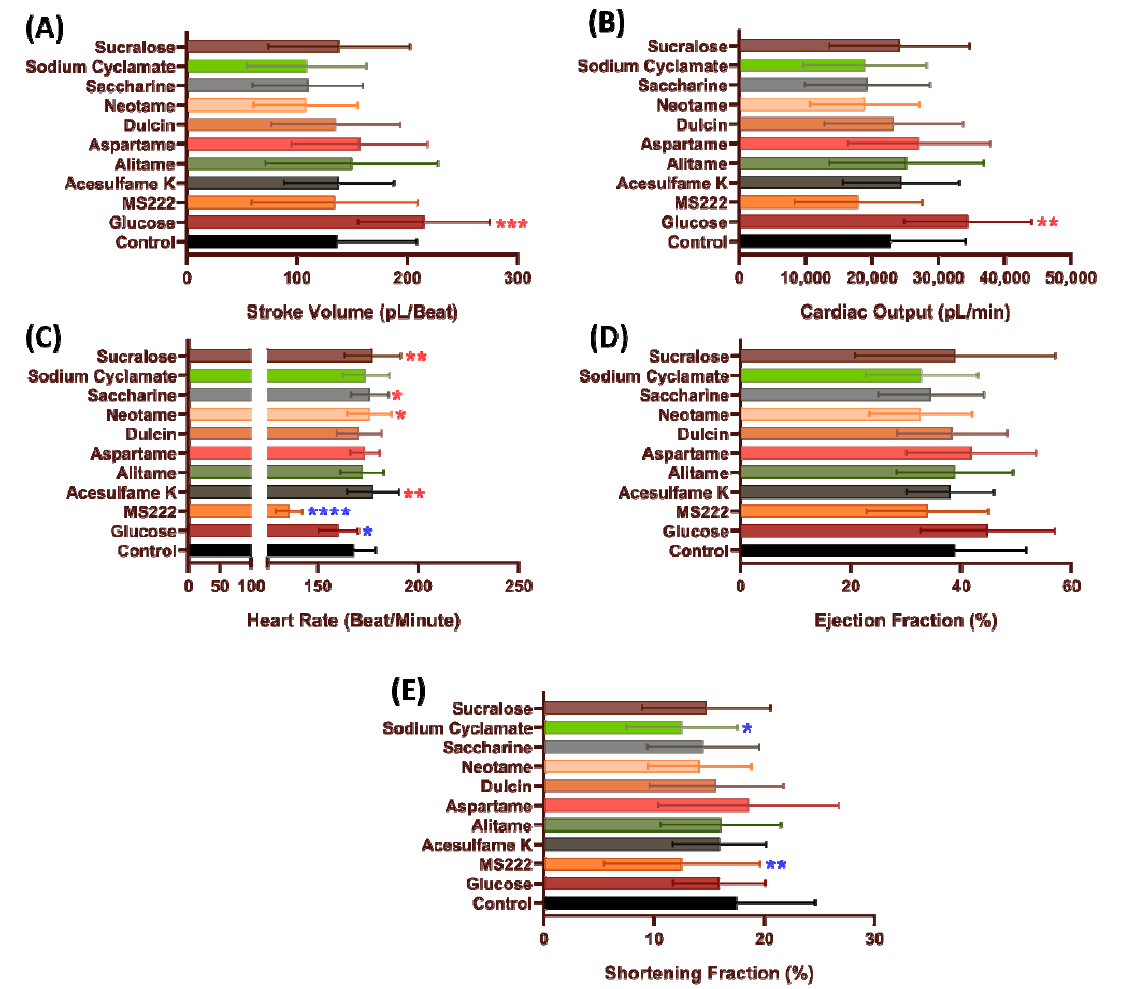
Figure 2. Cardiac performance endpoints for zebrafish after acute exposure to eight different artificial sweeteners at highest environmental relevant concentration (100 ppb). Cardiac physiology endpoints like ( A ) Stroke volume, ( B ) Cardiac output, ( C ) Heart rate, ( D ) Ejection fraction and ( E ) Shortening fraction were measured and compared. Data were presented as mean ± SD and statistical significances were tested by Ordinary One-Way ANOVA test followed by Fisher’s LSD test as post-hoc multiple comparison test ( n = 15). Red asterisk shows significant increase while blue asterisk shows significant decrease when compared to control. (* p < 0.05, ** p < 0.01, *** p < 0.001, **** p <